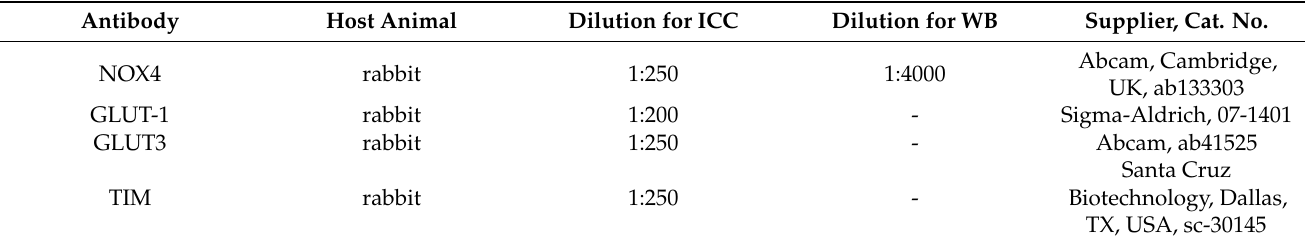
Table A1. Overview of the antibodies used for immunocytochemistry and Western blot analyses.